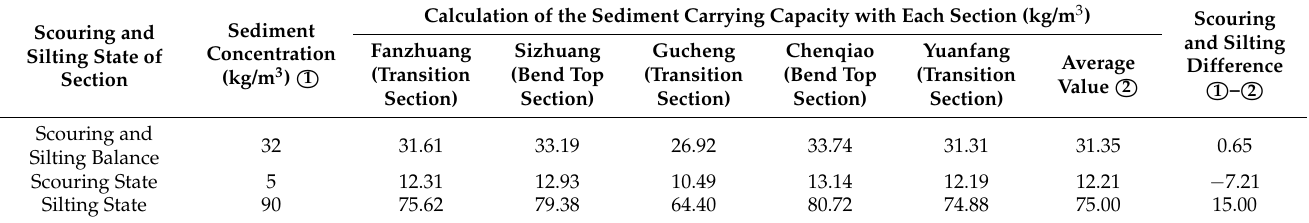
Table 6. Validation of scouring and silting state of Fanzhuang–Yuanfang section (5000 m 3